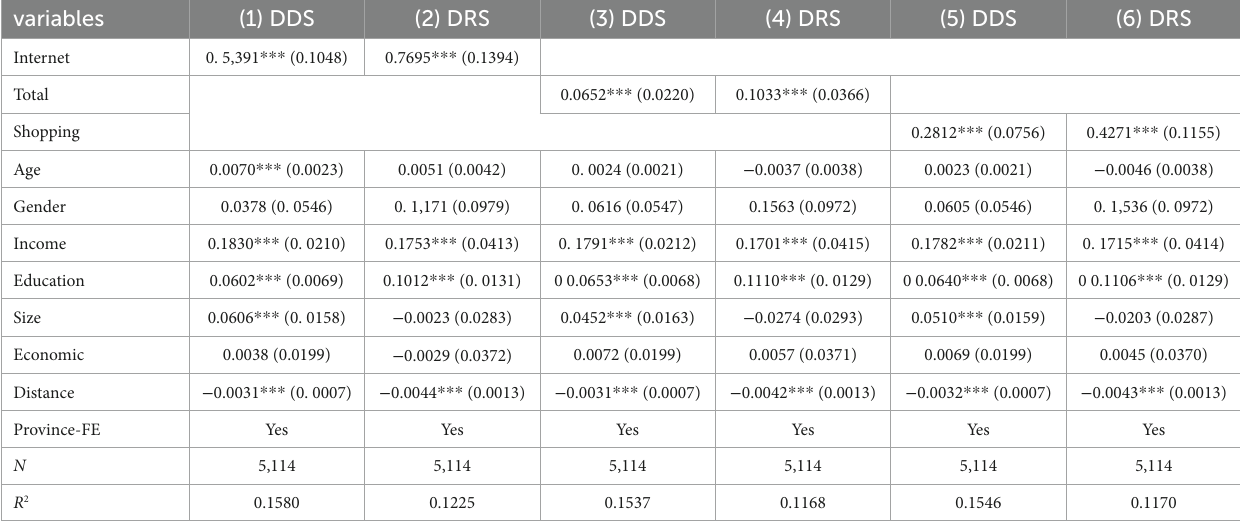
TABLE 2 Baseline regression results of the impact of Internet use on dietary diversity and dietary rationality of farm households.